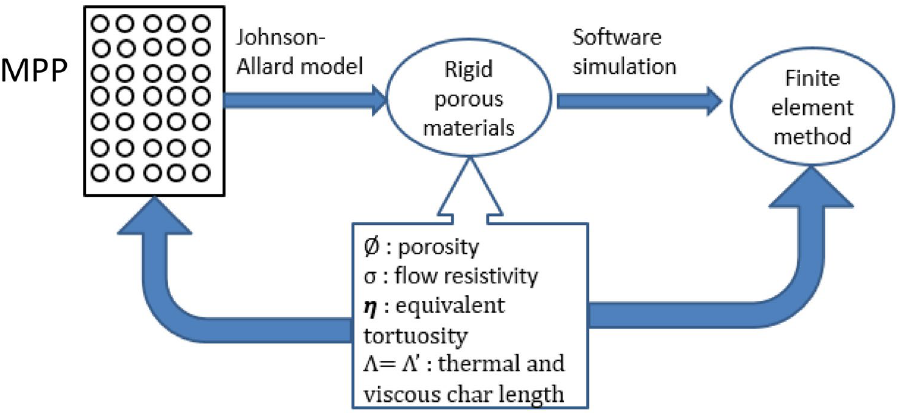
Figure 6. Equivalent fluid model conversion of MPP to rigid porous materials using the parameters of Ø, σ, η, Λ and Λ ʹ .